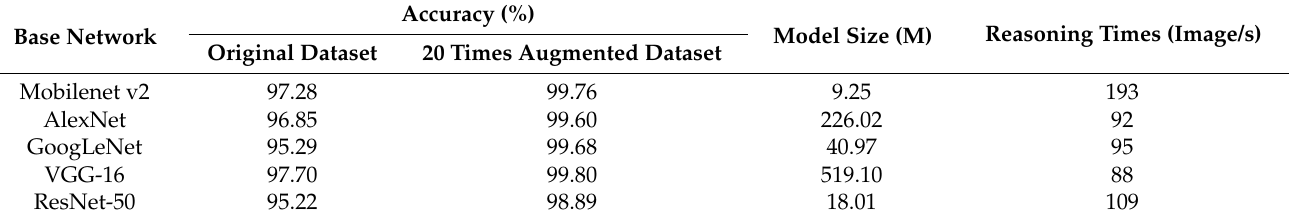
Table 2. Identification accuracy comparison of cow rump.